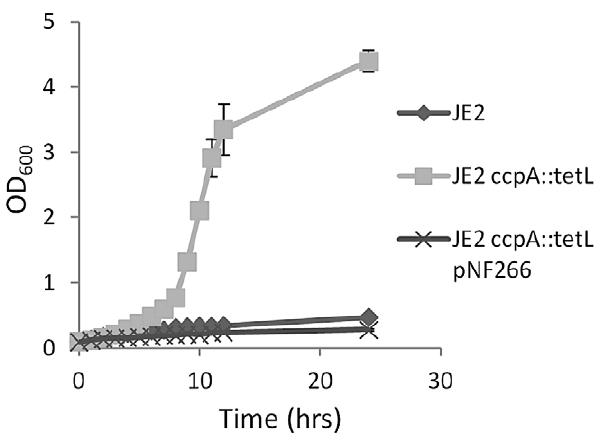
Figure 1. Interruption of ccpA facilitates growth in CDM-R. Growth analysis of JE2, JE2 ccpA::tetL , and JE2 ccpA::tetL/ pNF266 ( ccpA complement) in complete defined medium lacking arginine (CDM-R). Isolates were grown aerobically using a 10:1 flask to volume ratio. S. aureus strains containing a functional ccpA are unable to grow in CDM- R. Data represent means 6 SEM of three independent